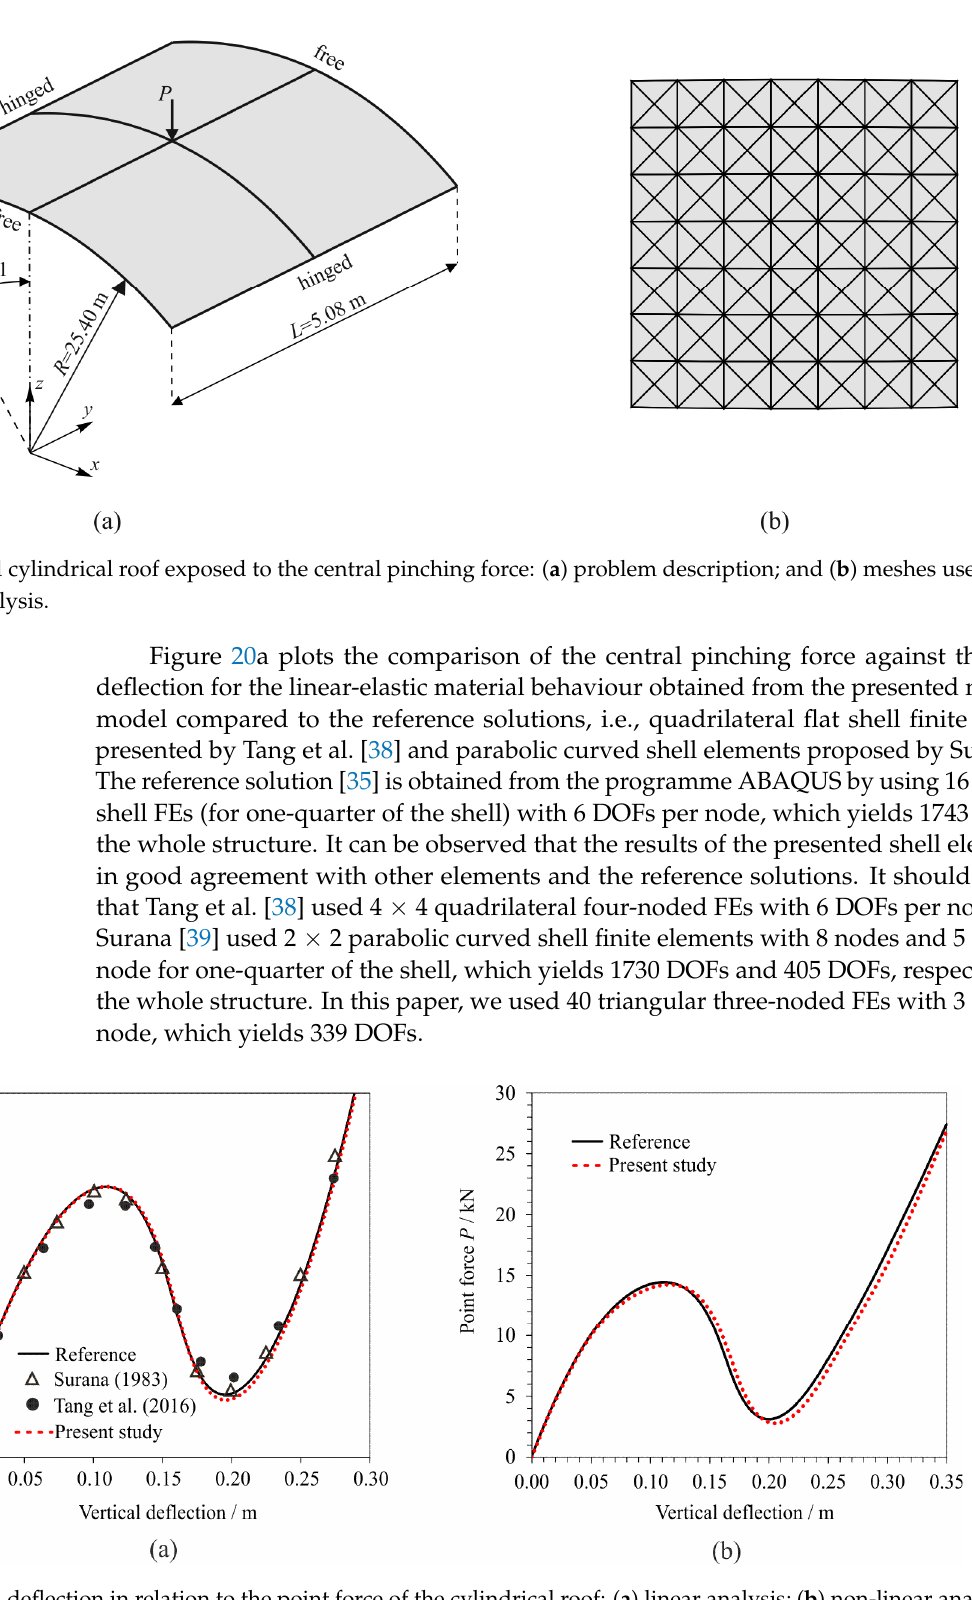
by using 25 × 25 S4R shell FEs for one-quarter of the shell. A relatively good agreement is